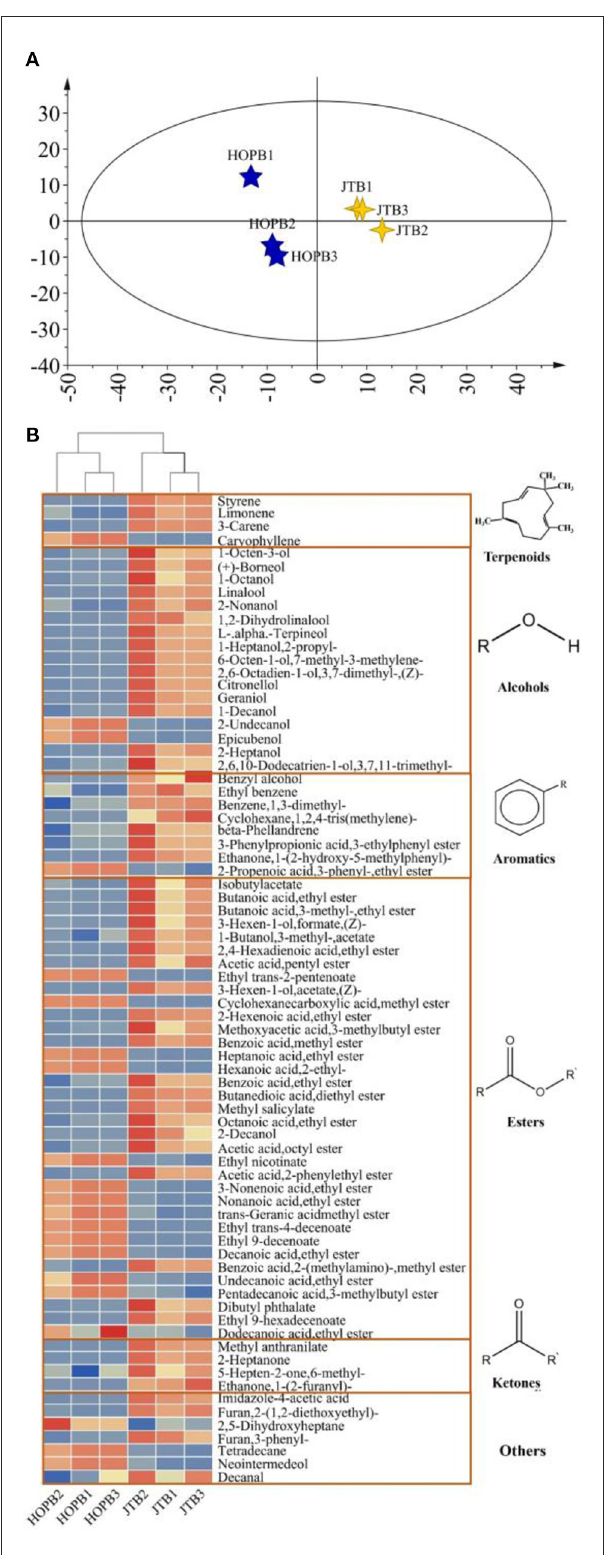
FIGURE3 Differential volatiles analysis in beer samples. (A) Score plot from OPLS-DA model; (B) Heat map of the relative content of key difference volatile